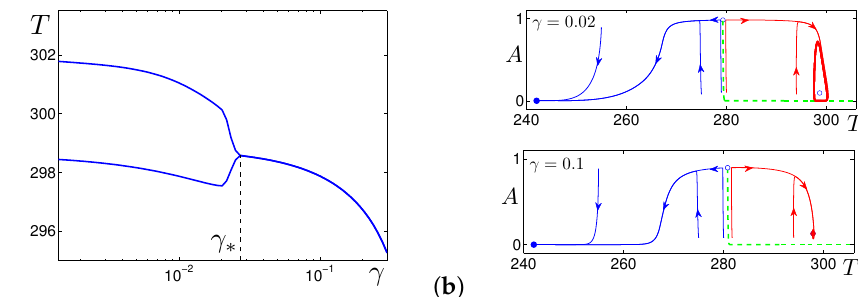
Figure 1. Deterministic system (1): ( a ) bifurcation diagram, ( b ) phase portraits. Here, the Andronov- = 0.0257. Hopf bifurcation point is γ ∗